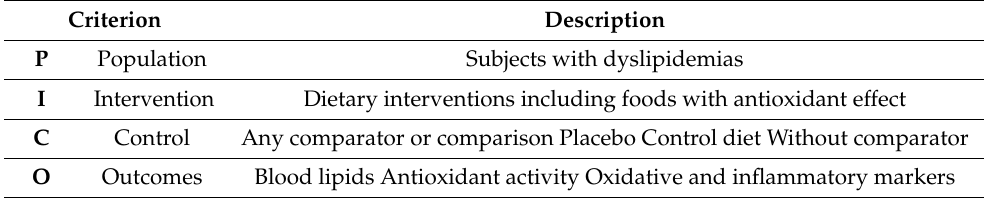
Table 1. PICO criteria for criteria for study